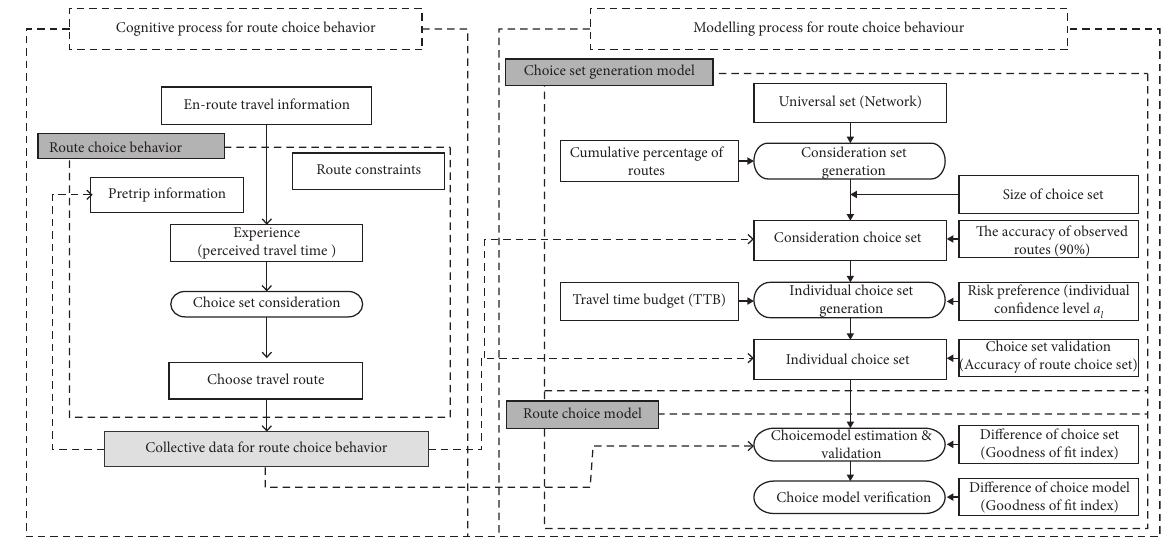
Figure 2: Modelling process for route choice